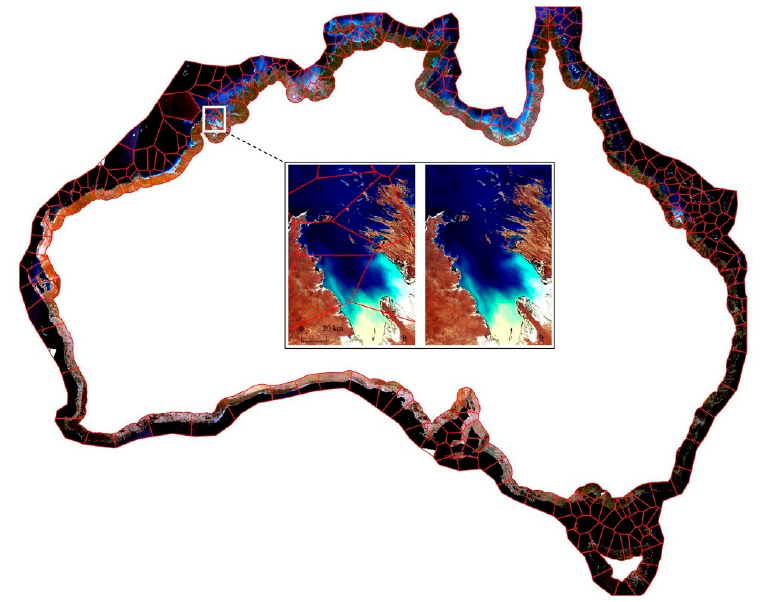
Figure 3 . Extent of the high and low tide composite products: inset shown at King Sound, Western Australia, illustrating the smooth and continuous transition between individually processed image polygons in the mosaic.